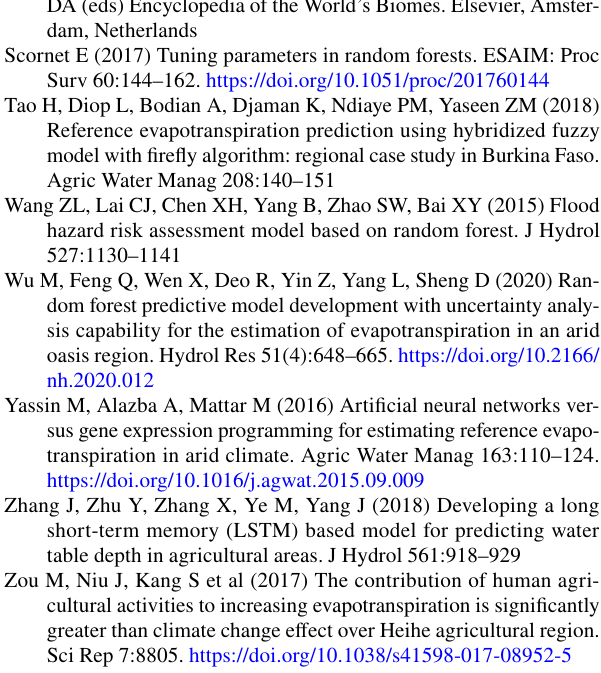
table depth in agricultural areas. J Hydrol 561:918–929 Zou M, Niu J, Kang S et al (2017) The contribution of human